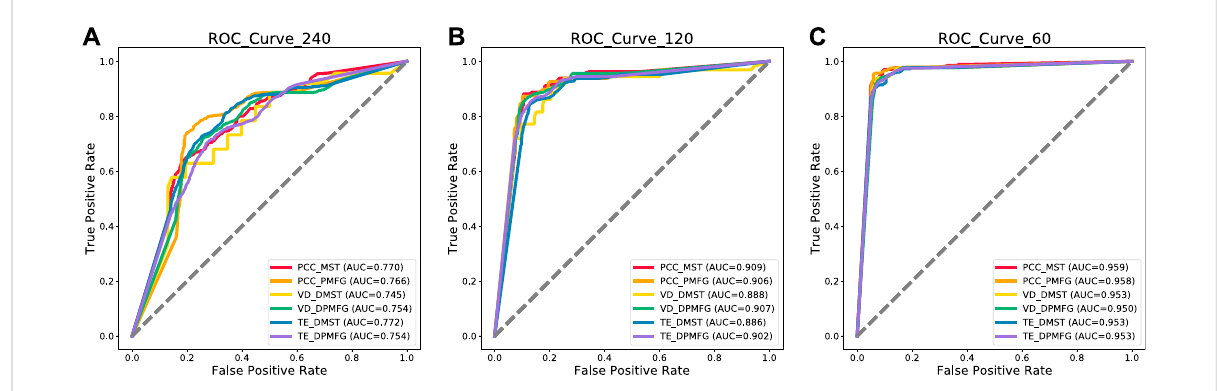
FIGURE 14 Predictionresultsofalltimeperiodsofeachwindow. (A – C) indicatepredictionresultsofalltimeperiodsat240-lengthscales,120-lengthscales and 60-length scales respectively.